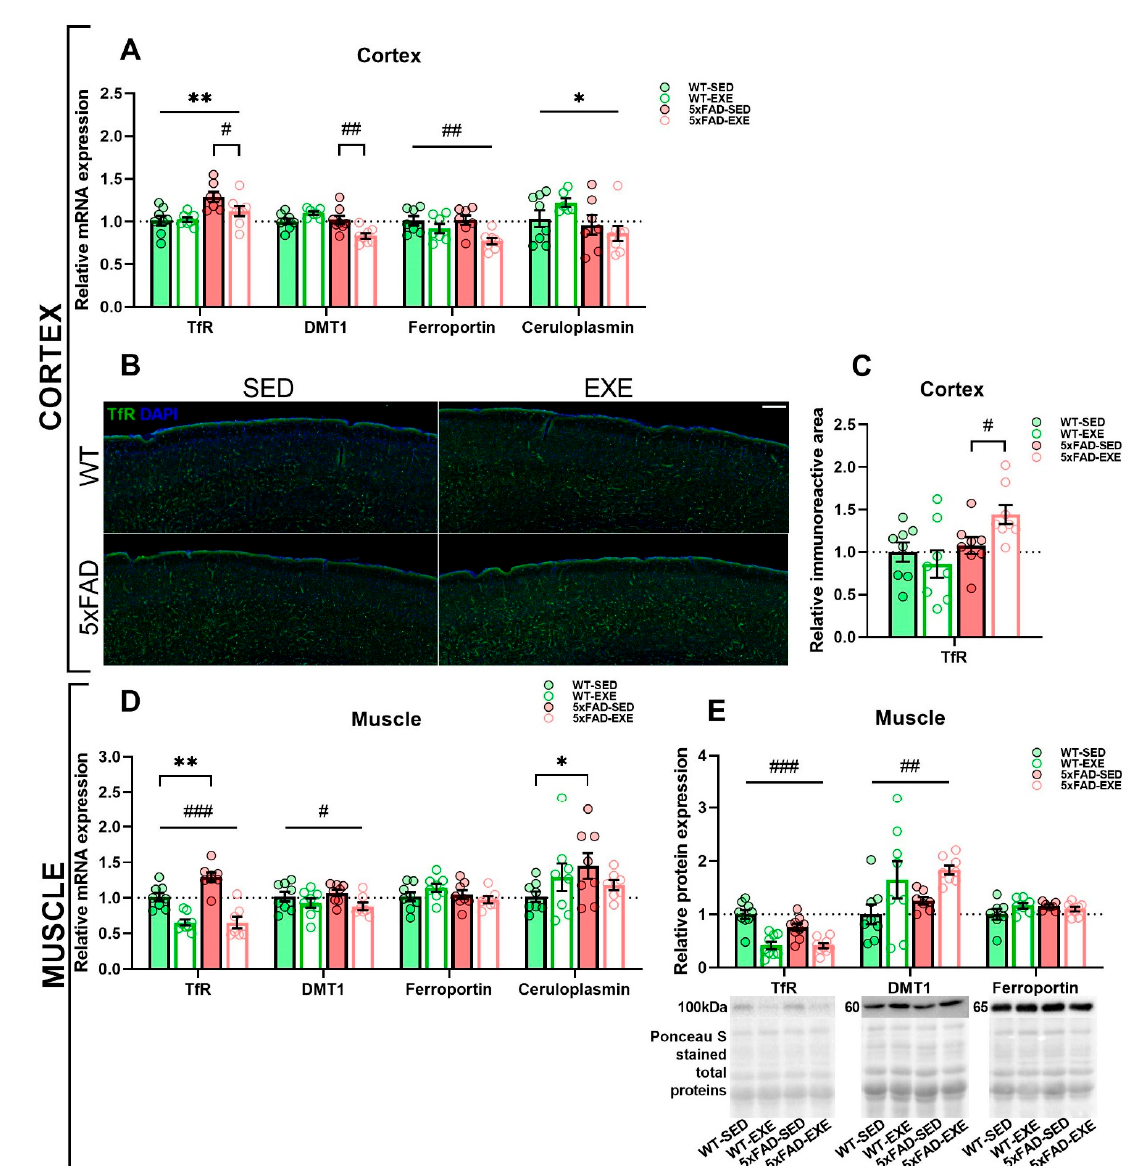
Figure 3. Effects of regular exercise on iron trafficking in cortex and muscle tissues in 5xFAD mouse model. Level of iron transporters and ferroxidase ceruloplasmin in cortex ( A – C ) and muscle samples ( D , E ) of WT and 5xFAD mice. mRNA expression of TfR, DMT1, ferroportin, and ceruloplasmin in the cortex ( A ) and muscle ( D ) was measured by qPCR. ( B ) Representative images of TfR levels in the cortex of WT-SED, WT-EXE, 5xFAD-SED, and 5xFAD-EXE mice. Scale bar 200 μ m. ( C ) Percentage of immunoreactive area was quantified to measure TfR level in cortex. ( E ) Representative Ponceau S staining and Western blot of TfR, DMT1 and ferroportin in muscle samples and the analysis of band intensities normalized to the total proteins. All data are presented as mean ± SEM. n = 8/group. «*» genotype effect, « # » exercise effect: ** p < 0.01, * p < 0.05, ### p < 0.001, ## p < 0.01, # p < 0.05. General genotype/exercise effect among all groups is presented as a line